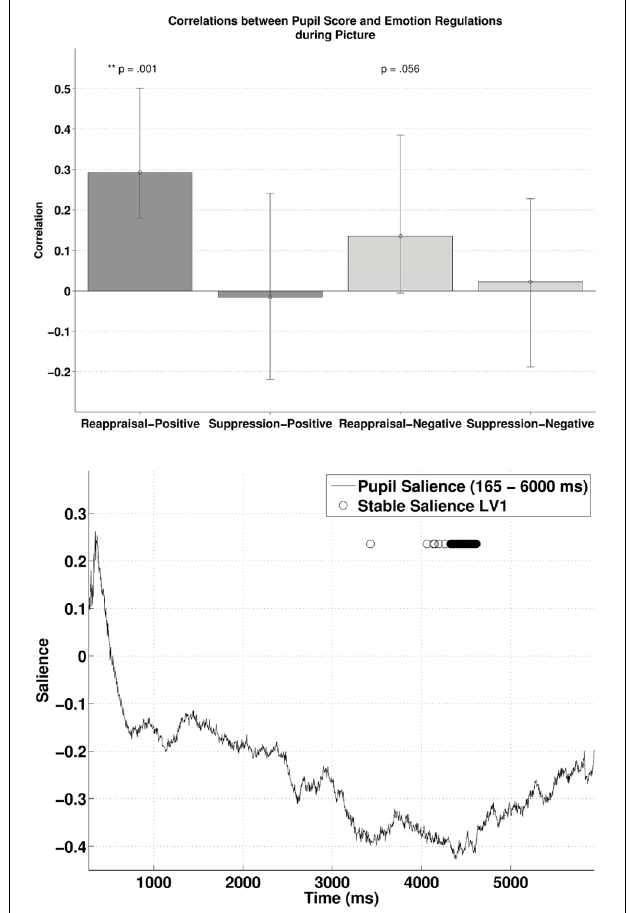
FIGURE 5 | The upper panel shows the correlations between participants’ pupillary responses and the ERQ scores in Latent Variable 1, with the scores derived from the difference in pupillary responses between cue and picture presentation phases (Picture minus Cue). Error bars represent boot-strapped 95% confidence intervals. The lower panel shows that the saliences are in general negative, implying that the reappraisal correlations are interpreted as: the higher the scores, the less positive/ more negative the difference in pupillary